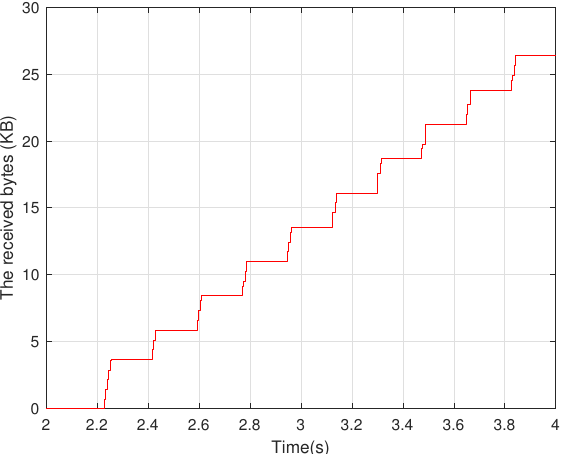
Figure 6. Received bytes of a stream with static